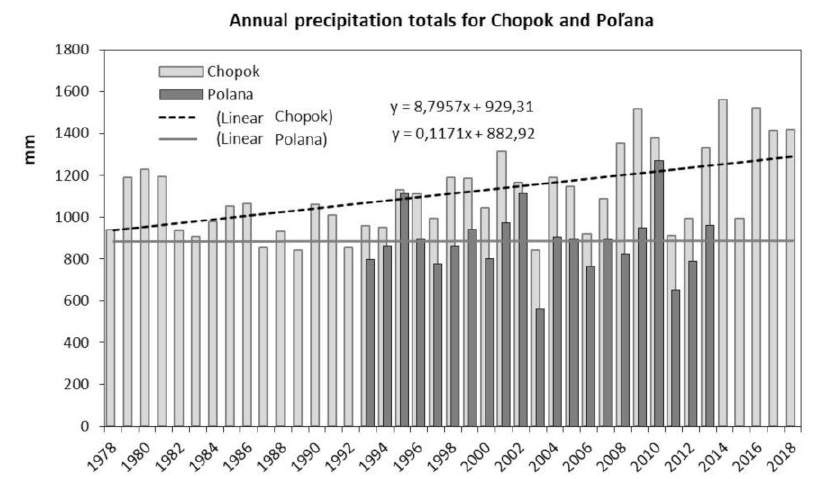
Figure 3. Annual precipitation totals for Chopok and